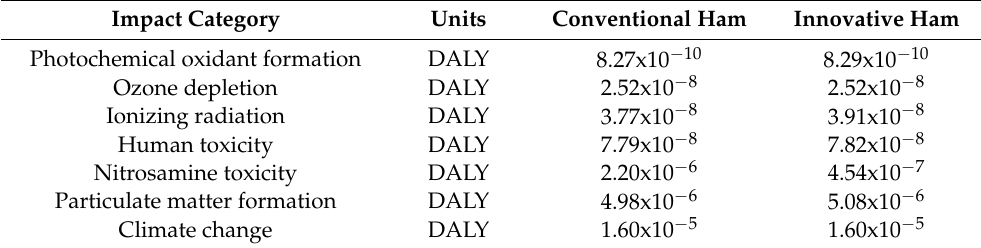
Table 5. Indicators of the human health impact categories of the cooked ham life cycle for two scenarios (conventional and innovative ham). Impact Category Units Conventional Ham Innovative Ham Photochemical oxidant formation DALY 8.27x10 − 10 8.29x10 − 10 Ozone depletion DALY 2.52x10 − 8